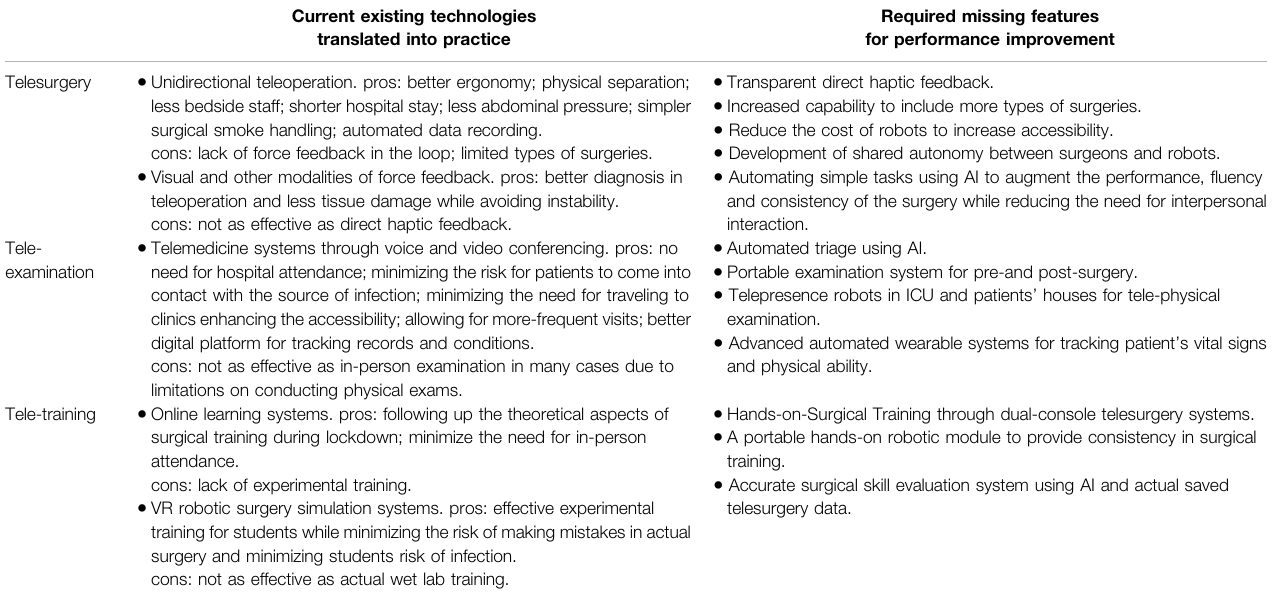
TABLE 1 | Existing technologies and required features in telesurgery, tele-examination, and tele-training. Current existing technologies translated into practice